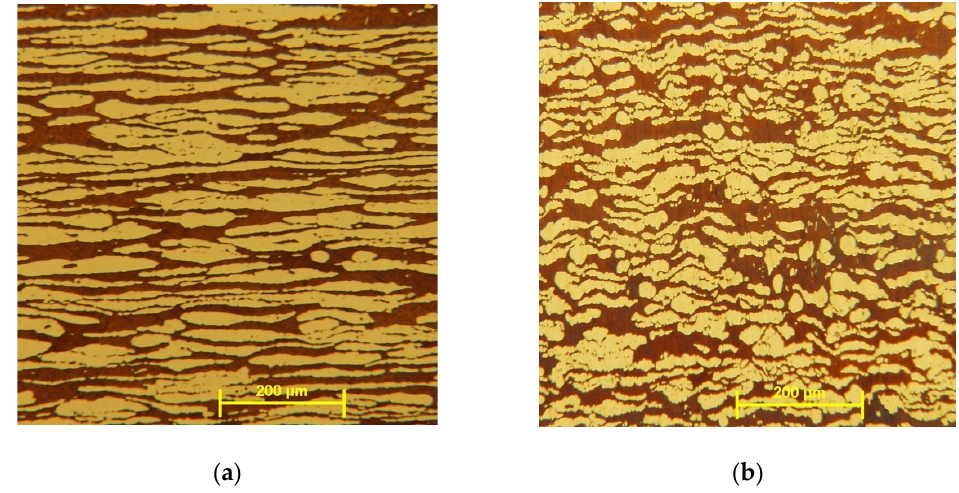
Figure 1. Optical microscopic image of two tested DSS specimens. ( a ) Initial state, longitudinal direction; ( b ) after a 61.9% rolling reduction, longitudinal direction.